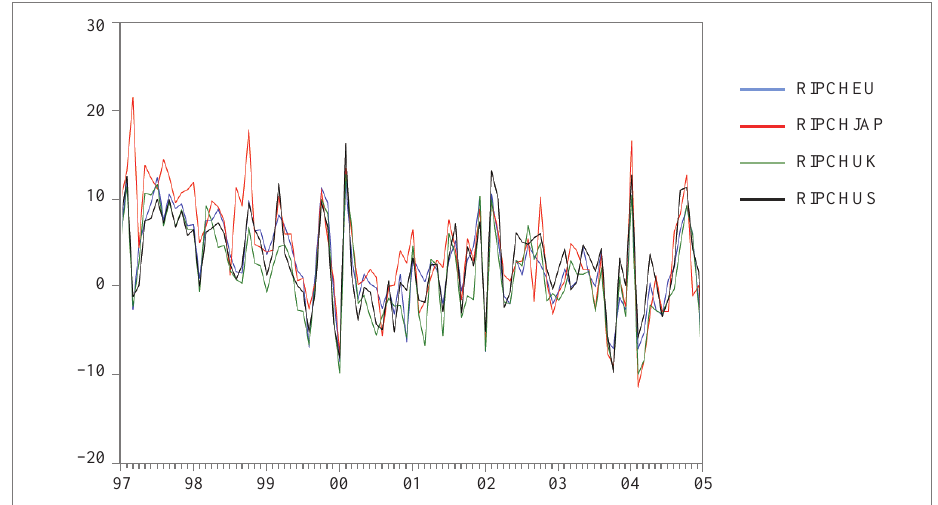
fig. 1. Real interest rate